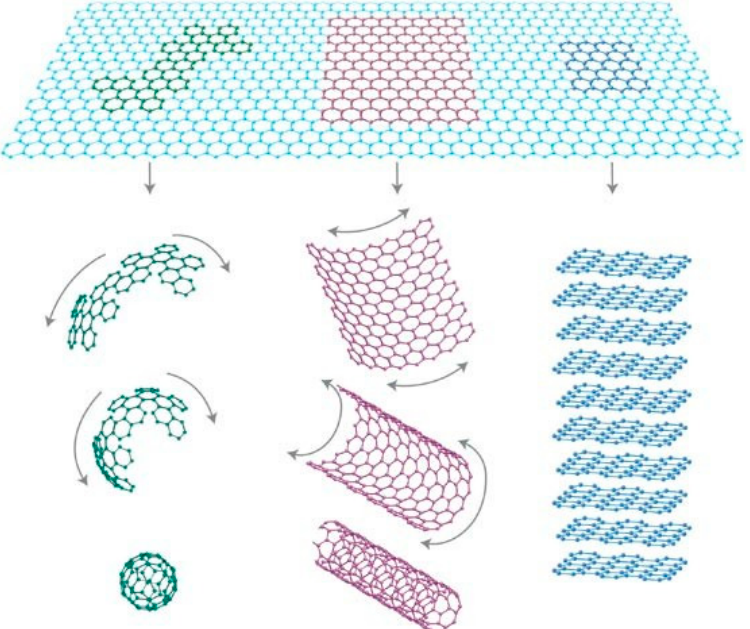
Figure 5. Schematic diagram of zero − dimensional fullerenes, one − dimensional carbon nanotubes, and three − dimensional graphite formed from graphene. (Reprinted with permission from ref. [44] .